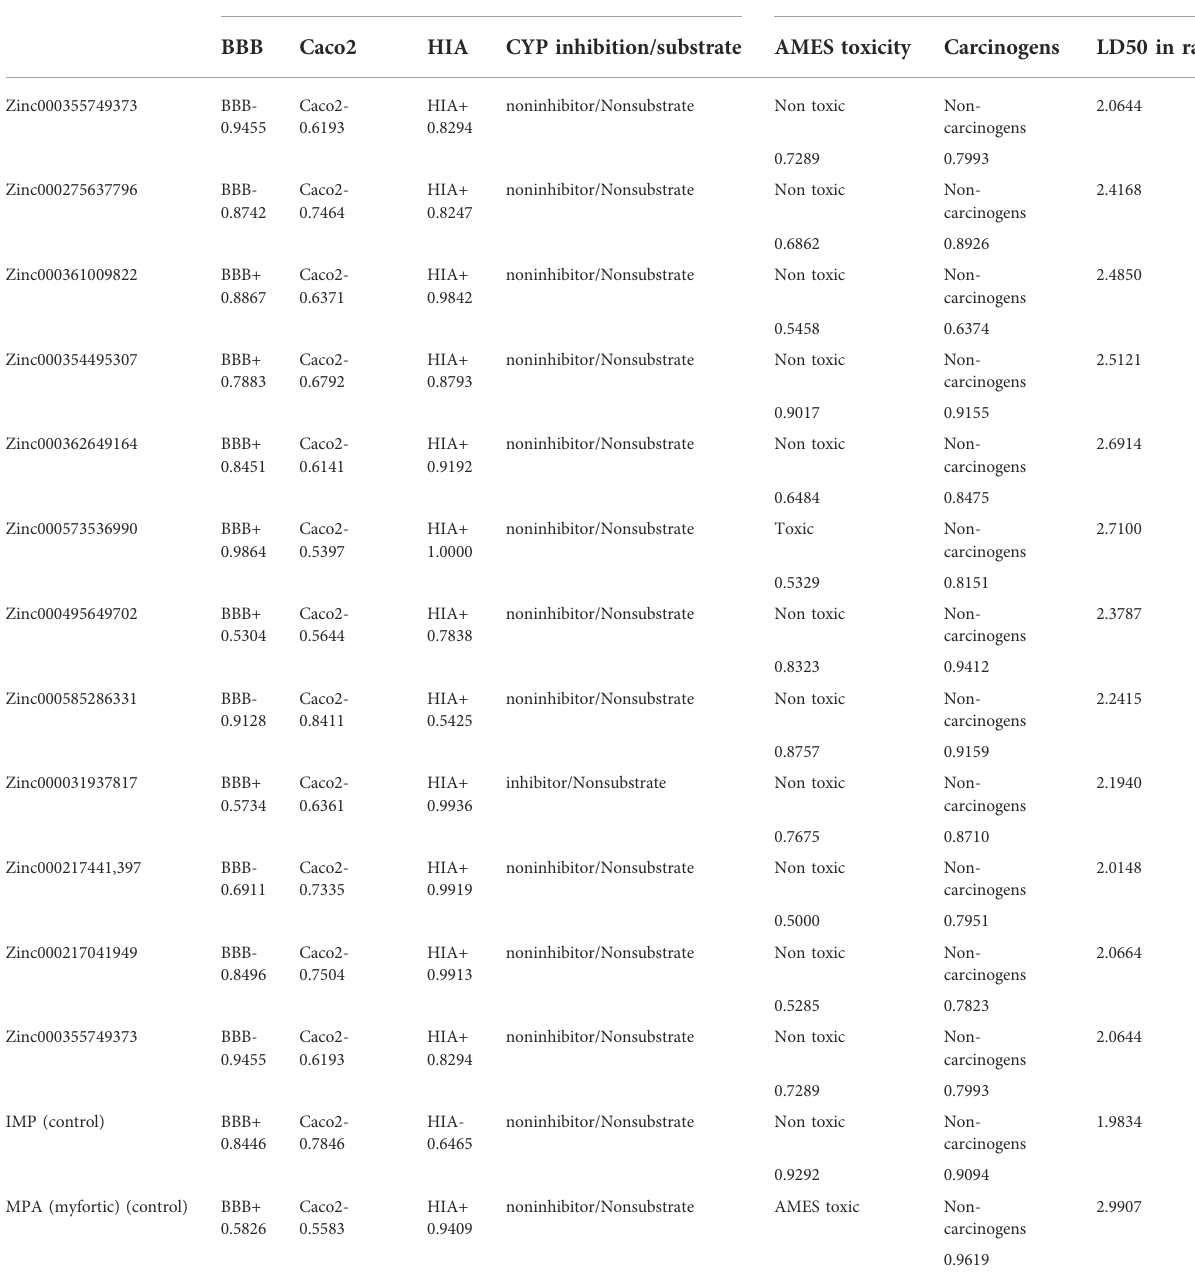
TABLE 5 ADME and Toxicity pro fi les of topmost ligands obtained from PreADMET and admetSAR server.